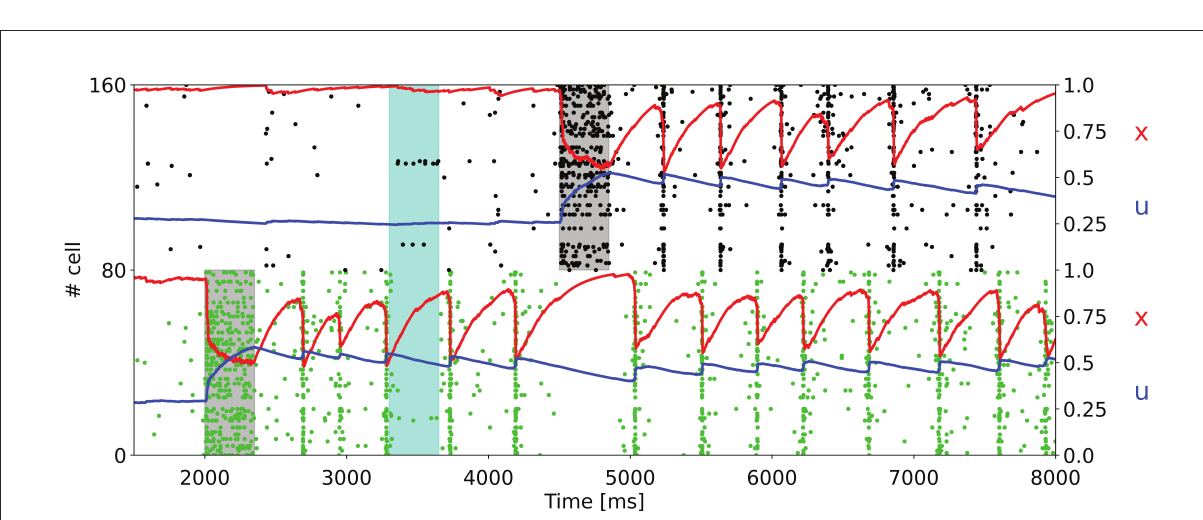
FIGURE5 Raster plot for a simulation with overlapping populations. Here only a subset of the two targeted selective populations is shown. An additional noise (cyan shading) is also injected. The network is in the bi-stable regime showing synchronous spiking activity.